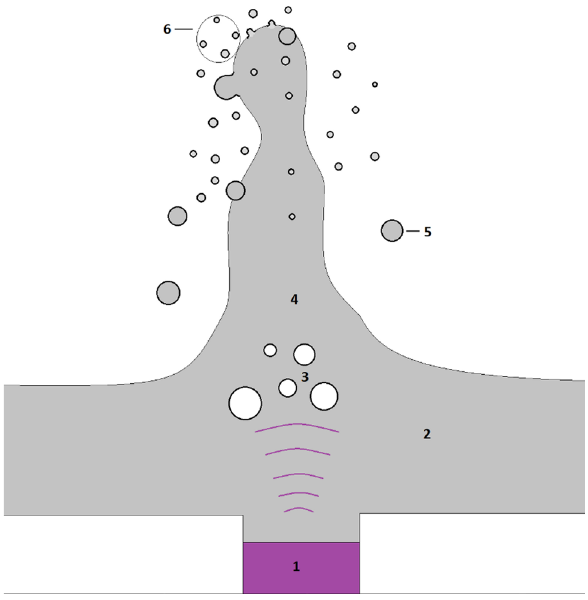
Figure 2. Ultrasonic atomisation schematics (1) Ultrasonic transducer (2) Liquid ink (3) Air bubbles (4) Standing wave (5) Big droplets falling back to container due to the gravitation (6) Aerosol